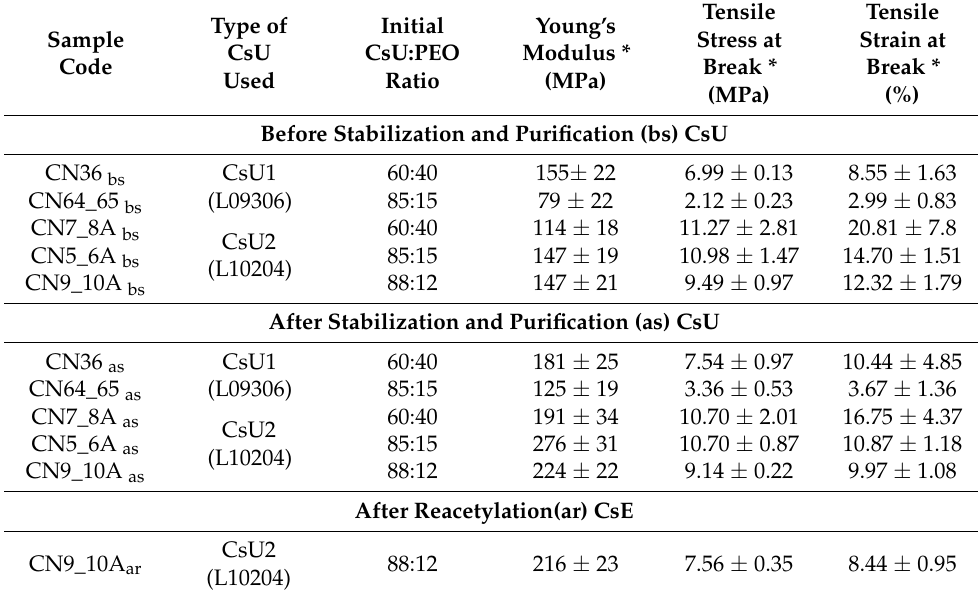
Table 4. Tensile properties of the electrospun chitosan (CsU) nanofiber mats before and after stabi- lization, and after reacetylation (CsE